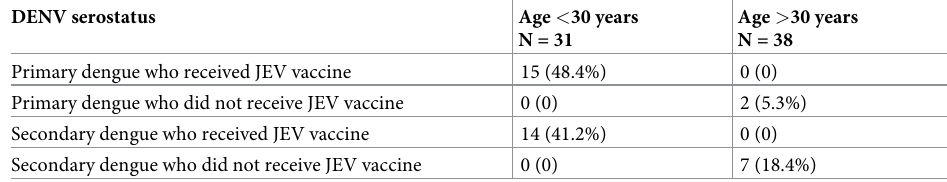
Table 1. Cross reactivity of these JEV peptides in the convalescent phase of those with acute dengue infection. DENV serostatus Age < 30 years